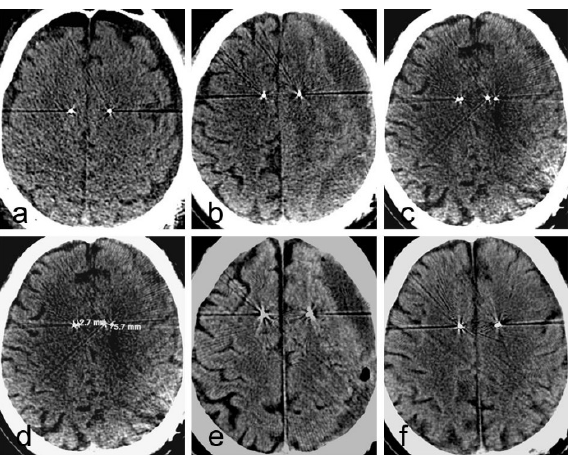
Figure 4. The change in CT images in patient 2. ( a ) On the first day after deep brain stimulation (DBS), CT shows bilateral subdural effusion and pneumocephalus, more obvious on the left side; ( b ) At 49 days after DBS, CT shows a CSDH on the left side, and a slight contralateral shift of the midline; ( c , d ) Fused with the early CT, the bilateral electrodes are substantially shifted; ( e ) At 3 days after drainage, CT fusion shows that the electrode shift is corrected; ( f ) At 77 days after drainage, CT shows complete hematoma absorption.